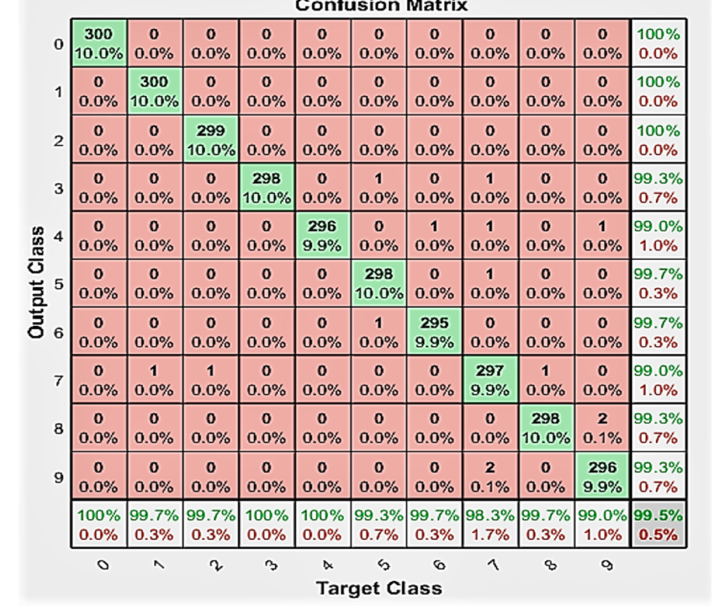
Fig. 9 Confusion matrix of the validation accuracy of architecture 5 for MNIST